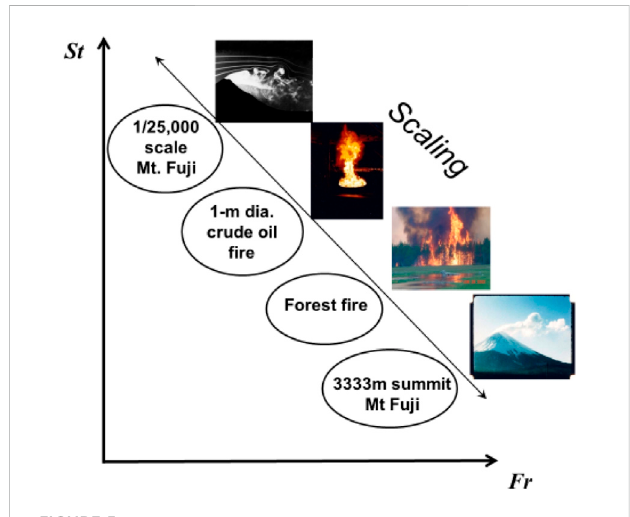
FIGURE 5 The Strouhal number - the Froude number scaling correlation to connect phenomena separated by 10 5 orders of magnitude in the characteristic